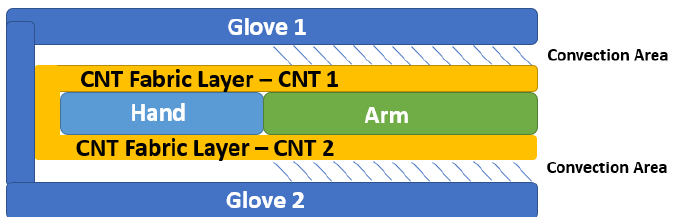
Figure 4. Simulation of an AT glove for FFs—Design of the glove. Glove 1 is the top outer layer of the glove, glove 2 is the bottom outer layer of the glove. CNT 1 is the top inner layer of the glove. CNT 2 is the bottom inner layer of the glove. The convection area is the area in which air flow from the air pump cools the glove. The thermal properties of the hand and arm are modeled in the simulation. A cold area to provide cooled air is not shown. The drawing is not to scale.